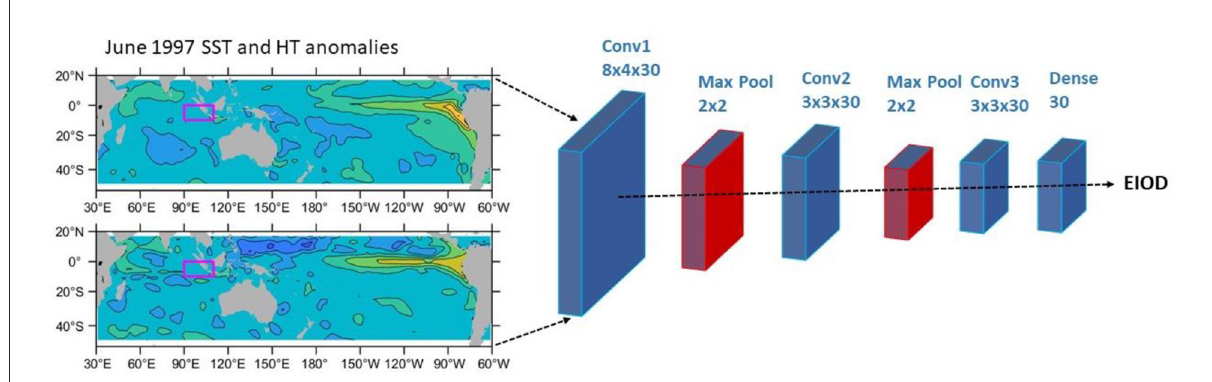
FIGURE1 The structure of the CNN model. Input data domain is shown on the left as SST (upper) and heat content (lower) anomalies in the Indo-Pacific for an example month of June 1997. The focal region for the EIOD is shown by the magenta box (10 ◦ S-equator, 90–110 ◦ E). The first convolution layer of the CNN model is 8 × 4 with 30 filters, followed by a 2 × 2 maximum pooling layer; the second convolution layer is 3 × 3 with 30 filters, followed by a 2 × 2 maximum pooling layer; and the third convolution layer is also 3 × 3 with 30 filters, followed by a dense layer with 30 filters, before output to the monthly EIOD